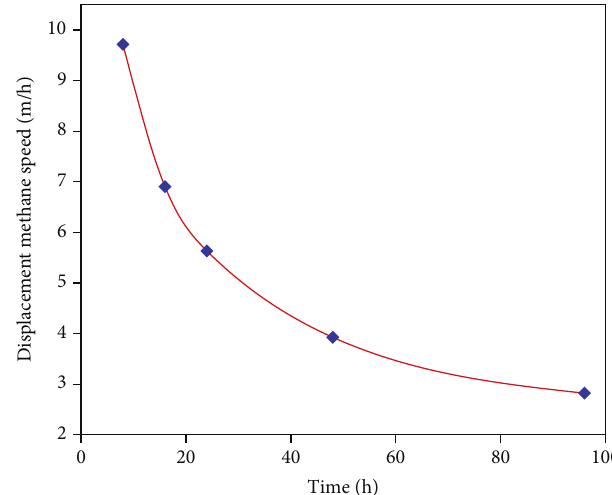
Figure 23: Average methane displacement